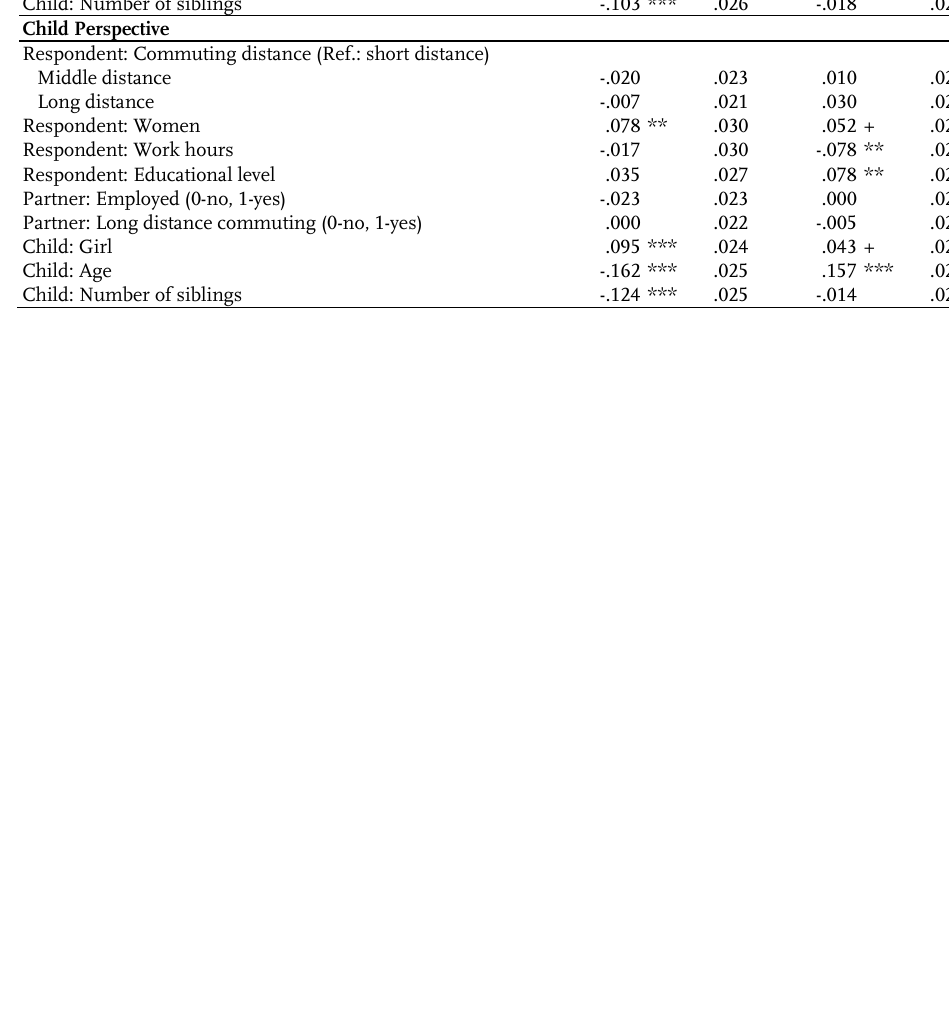
Table 4 : The association between parents’ long-distance commuting and the parent-child relationship (measured by esteem and conflict) Parent